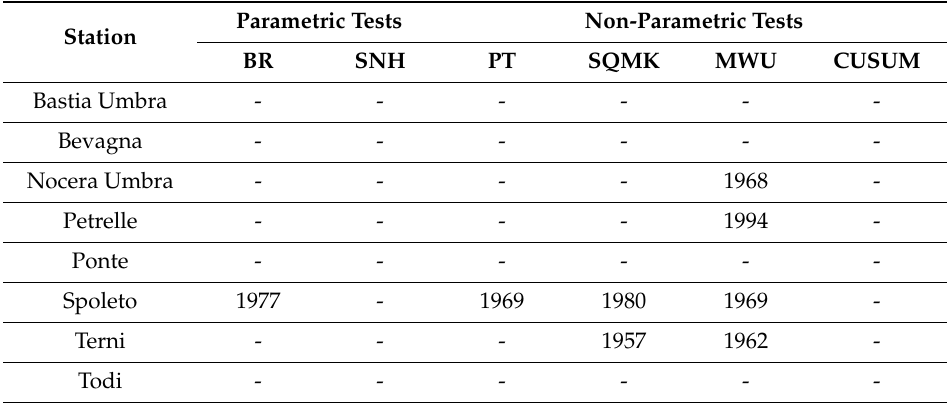
Table 4. Summary of the years in which break points were detected by the applied tests. Parametric Tests Non-Parametric Station